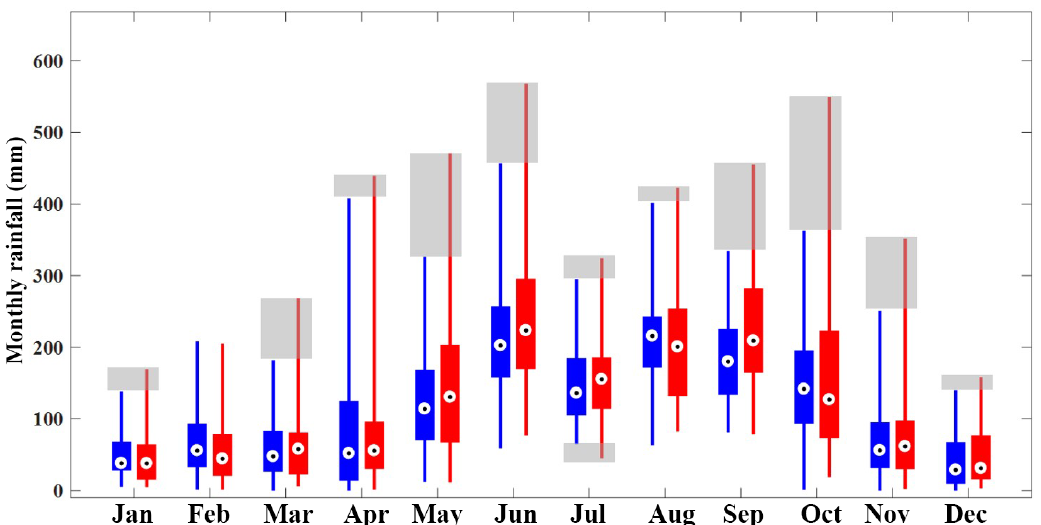
Figure 2. Box plots of the observed monthly rainfall at gauge NCDC-85663 in Florida, USA (red). The box plots of the synthetic monthly rainfall generated by the Modified Bartlett–Lewis Rectangular Pulse model at the same gauge are shown for reference (blue). Whiskers reach minimum and maximum values of monthly rainfall during the period between 1961 and 2010, and grey shaded boxes represent the discrepancy in the variability of the two monthly rainfall